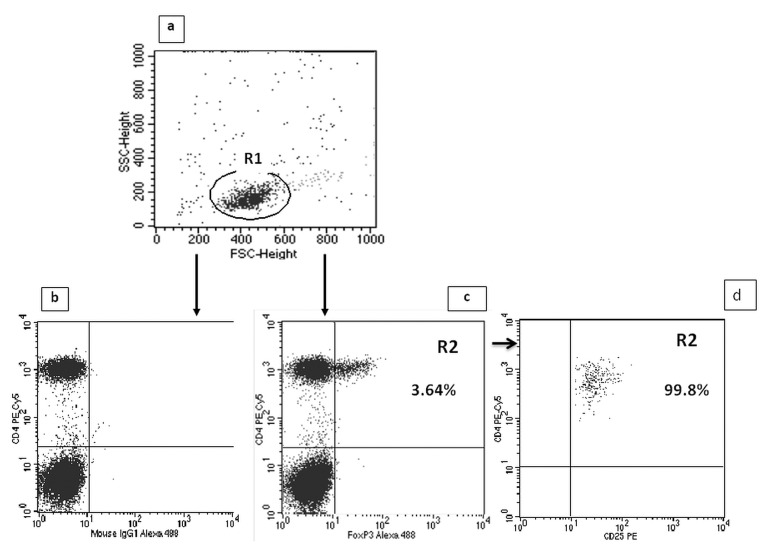
Evaluation of CD4+CD25highFoxP3+ (Treg) cells frequency in ALD patients by flow cytometry.A. The lymphocyte subpopulation was gated (R1) based on linear forward vs. side scatter (FSC/SSC) characteristics. B. Dot plots of CD4 PE-Cy5 versus mouse IgG1 Alexa Fluor 488 were established (controls). C. Dot plots of CD4 PE-Cy5 versus the intracellular expression of FoxP3 Alexa Fluor 488 in CD4+ T cells were established. The R2 region represents the percentage of CD4+CD25highFoxP3+ (Treg) cells among all CD4+CD25+ lymphocytes. D. 99.8% of cells gated as CD4+FoxP3+ (R2) were CD25 high.